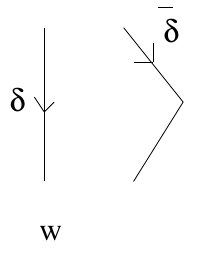
Figure 21 . Another